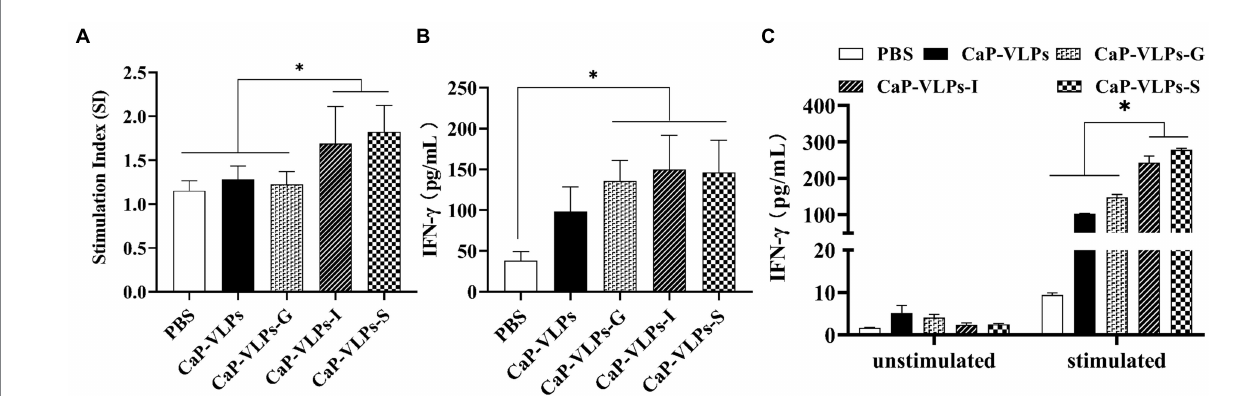
FIGURE 4 The cellular immune response induced by CaP-VLPs in mice. (A) Detection of T-lymphocyte proliferation on day 28 after the first immunization. (B) Content of IFN- γ in the serum of mice on day 28 after the first immunization. (C) Changes of IFN- γ content in spleen lymphocyte culture supernatant before and after antigen stimulation. Asterisks indicate a significant difference (* p < 0.05).